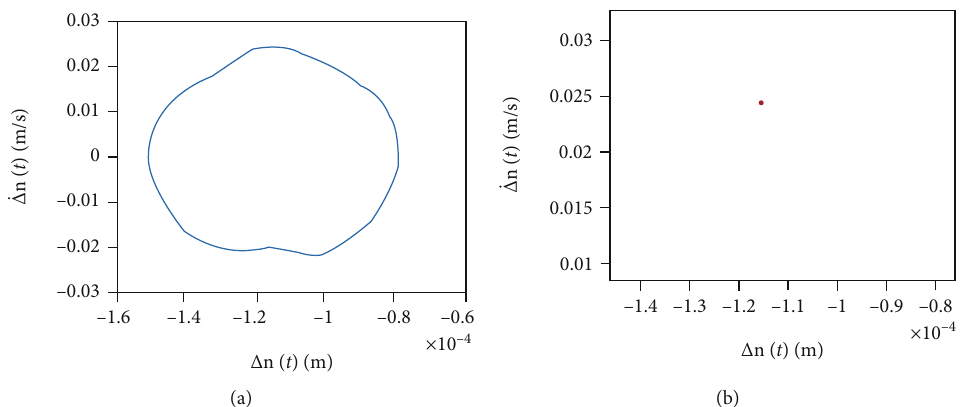
Figure 17: When the wear is 1 : 59 × 10 − 5 m (the misalignment in the x direction is 2 : 8 × 10 − 4 m): (a) relative displacement velocity and (b) the corresponding diagram of Poincare.